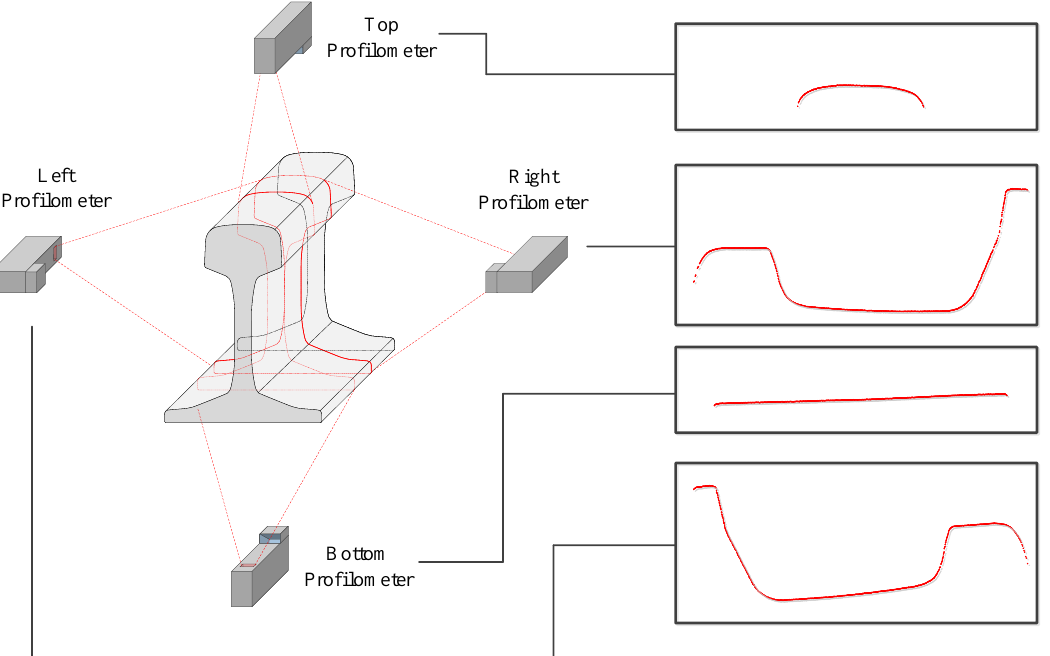
Figure 9. Rail profile